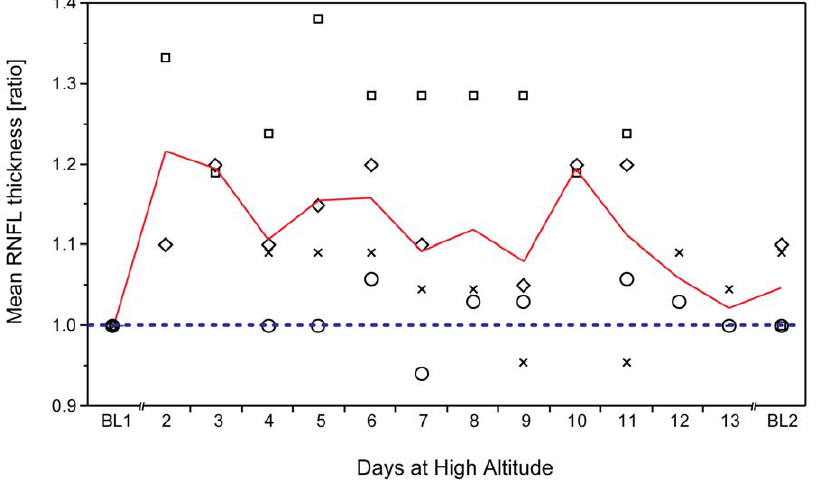
Figure 5. Optic disc edema during long term exposure at high altitude. Optic disc edema (ODE) persists beyond acclimatization. Mean retinal nerve fiber layer (RNFL) thickness ratios in four participants with extended exposure to altitude at CM (4559 m) indicate elevated ratios for RNFL thickness up to day12 of exposure. Blue dashed lines indicate BL1 level; red lines indicate mean; n day2, 12–13 =2, n day3–7, 9–11 =4, n day8 =3. doi:10.1371/journal.pone.0027022.g005 PLoS ONE |